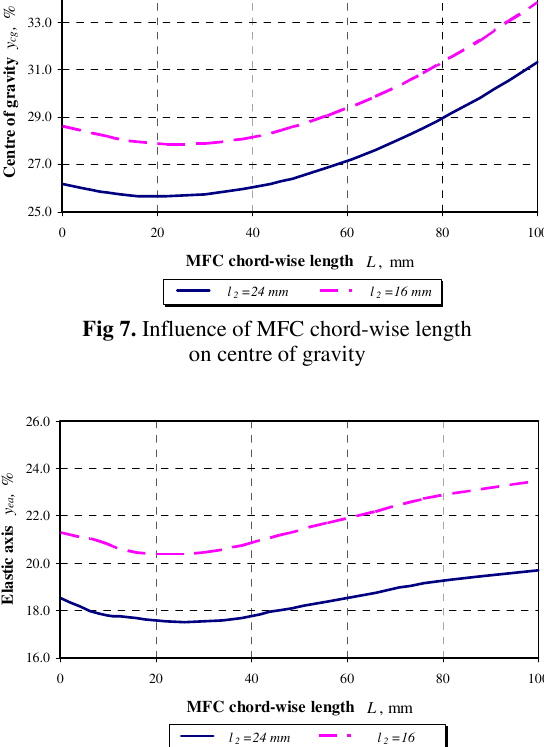
Fig 8. Influence of MFC chord-wise length on elastic axis